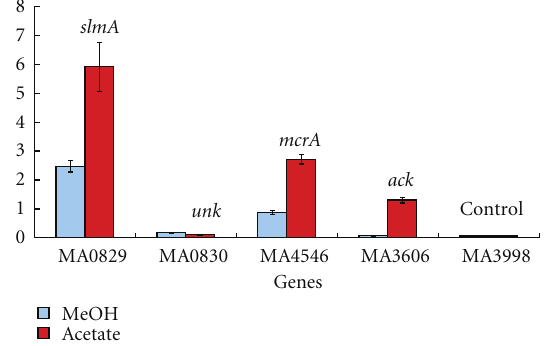
Figure 4: Expression levels of the MA0829 and MA0830 genes in M. acetivorans relative to methyl-Coenzyme M transferase ( mcrA ) and acetate kinase ( ack ) genes. RT-PCR expression data for the indicated genes in cells grown on methanol versus acetate as the carbon supply. Abundance values (AU) are expressed as copy number